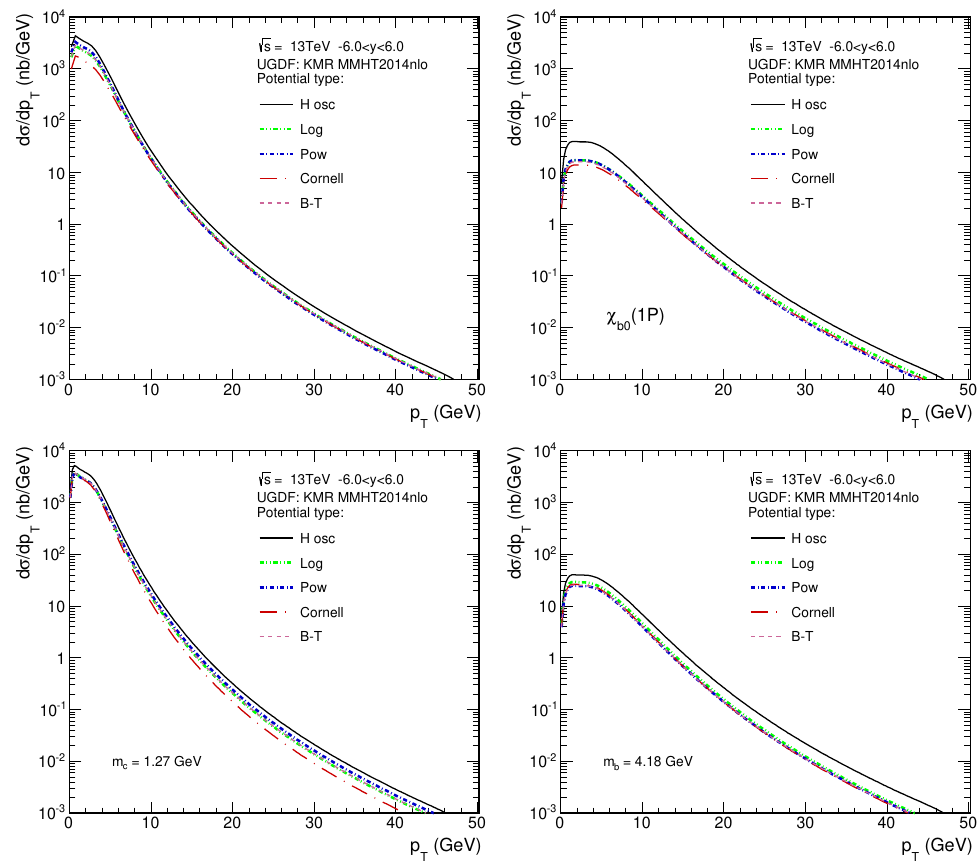
Figure 8 . Comparison of p T distributions for (cid:12)ve di(cid:11)erent potentials types with corresponding quark mass in the (cid:12)rst row, and the second row is with identical (for all potentials) m c = 1 : 27 GeV and m b = 4 : 18 GeV used in calculating form factors. Here the KMR UGDF was used for (cid:31) c 0 (1P) (left panel) and (cid:31) b 0 (1P) (right panel).